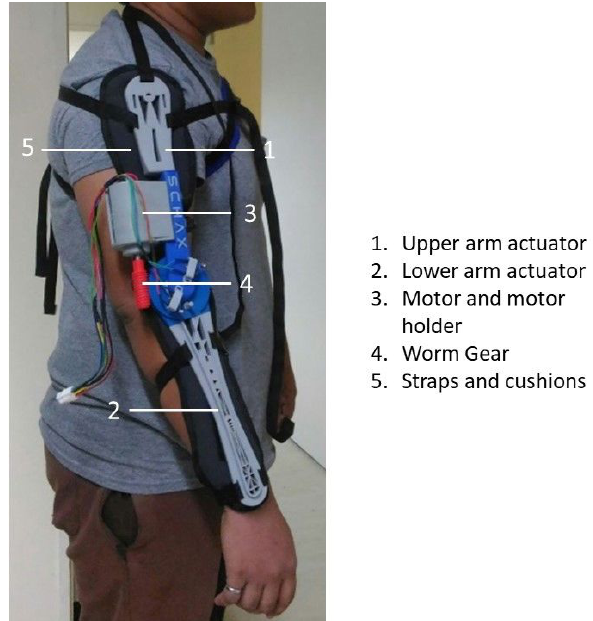
Figure 15: Upper and lower arm actuators assembly